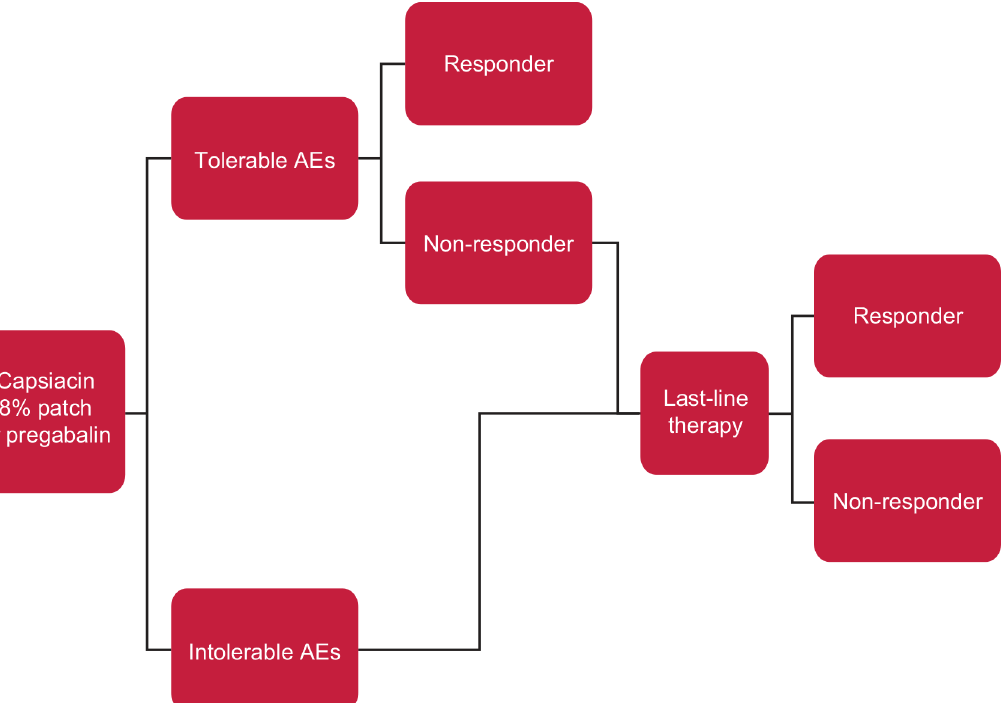
Fig 1. Decision-tree model. Key: Responder: (cid:1) 30% reduction in “ average pain for the past 24 hours ” according to the NPRS score. Non-responder: < 30% reduction in “ average pain for the past 24 hours ” according to the NPRS score. Tolerable AE: persistent AE typically including dizziness, nausea and somnolence, which do not result in treatment discontinuation. Intolerable AE; AE that result in treatment discontinuation. Abbreviations : AE, adverse event; NPRS, Numeric Pain Rating Scale.